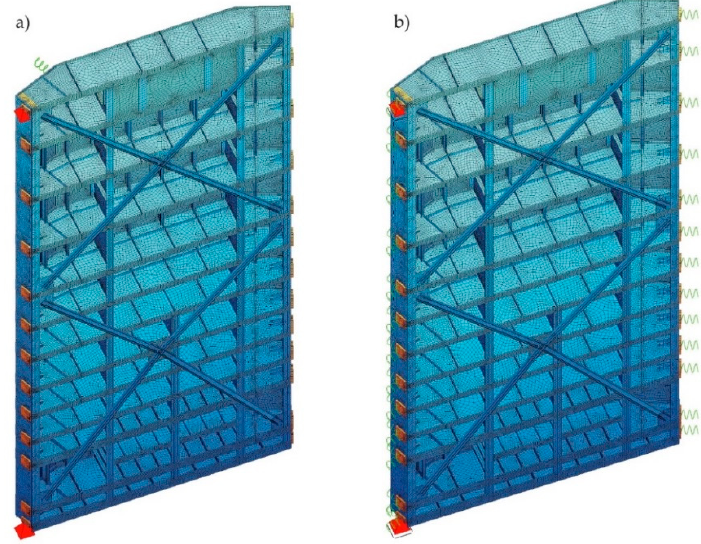
Figure 5. Visualization of the numerical models with di ff erent boundary conditions. ( a ) “Opened Figure 5 . Visualization of the numerical models with different boundary conditions. ( a ) “Opened model”; ( b ) “Closed model”; ( b ) “Closed model”.